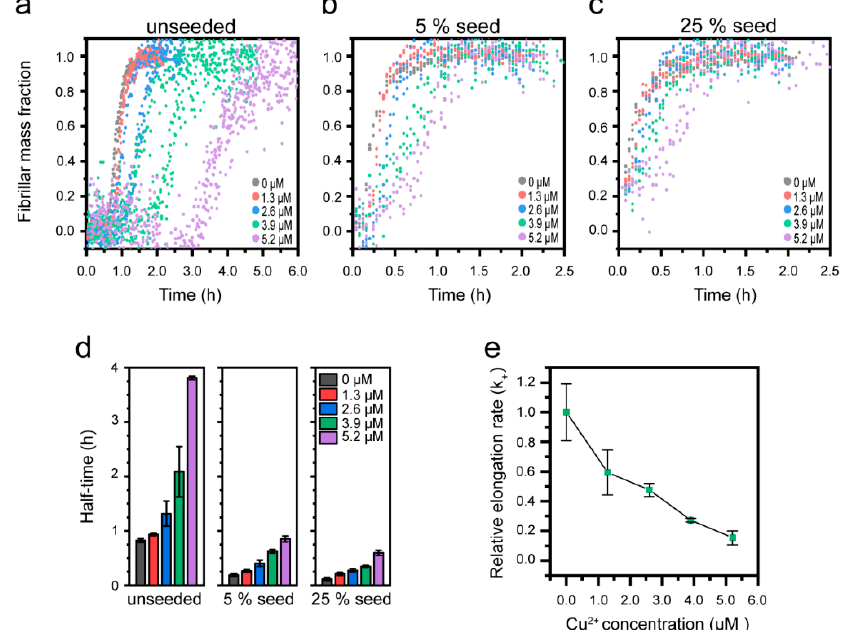
Figure 4. Effect of Cu 2+ on seeded A β (1-42) amyloid formation at pH 8.0 (a– c ) Normalized kinetic profiles of 2.6 μ M A β (1-42) in presence of indicated concentrations of Cu 2+ in reactions with ( a ) no seeds, ( b ) 5% seeds, and ( c ) 25% seeds. ( d ) Half-times of A β (1-42) aggregation, extracted from the data in (a-c). Error bars represent the standard deviation (n=3). ( e ) Relative elongation rate of 2.6 μ M A β (1–42) in presence of 25% seeds as a function of Cu 2+ concentration, as estimated using a linear approximation of the kinetic slope up until a fibril mass fraction of 0.5. All the rate constants are relative to that of 2.6 μ M of A β (1-42) in absence of Cu 2+ .